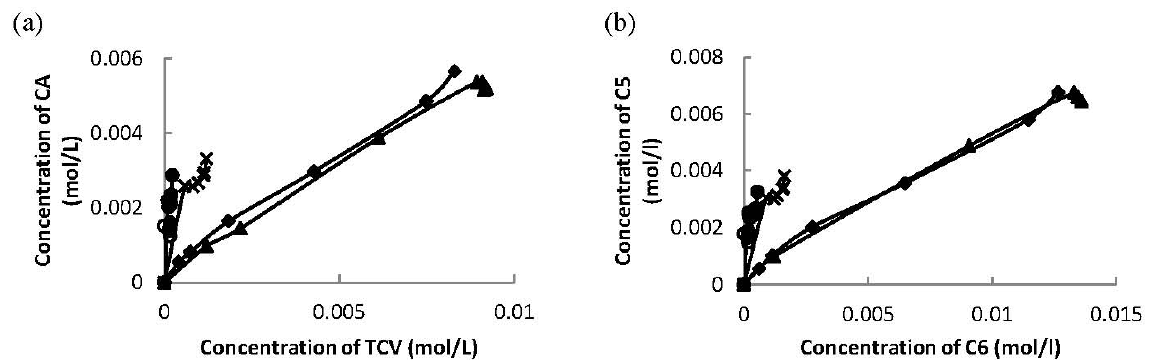
Figure 9. ( a ) The concentrations of campholenic aldehyde versus concentrations of trans -carveol and ( b ) concentrations of C5 products (sum of concentration of campholenic aldehyde and fencholenic aldehyde) versus concentrations of C6 products (sum of concentration of trans -carveol and 2-methyl-5-(propan-2-ylidene)cyclohex-2-enol) over 32 wt % Ce–Si–MCM-41 using various solvents: DMA ( ♦ ), NMP ( ▲ ), pentan-2-ol ( X ), THF (o) and acetonitrile ( ● ).